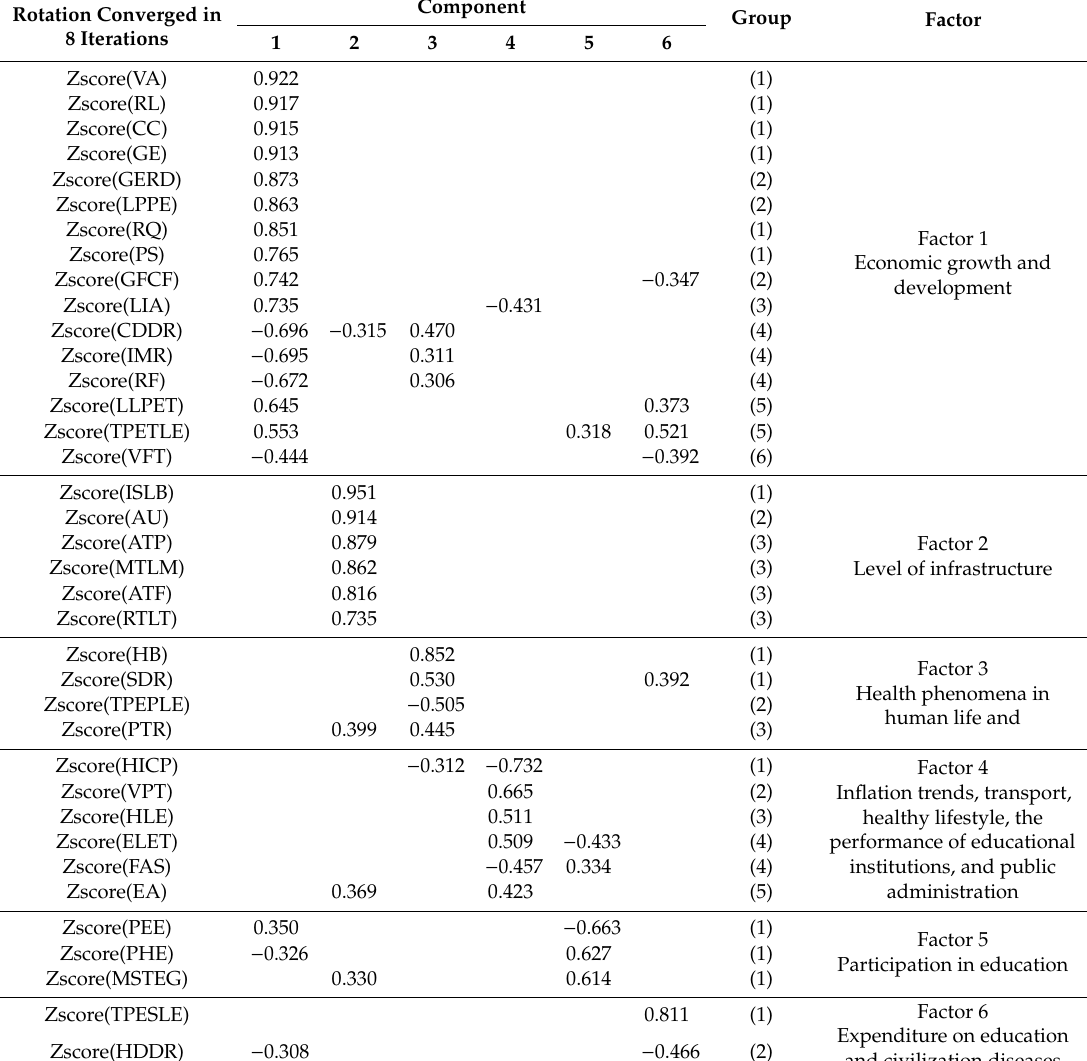
Table 4. Input factors—rotated component matrix (source: own calculation and elaboration). Rotation Converged in 8